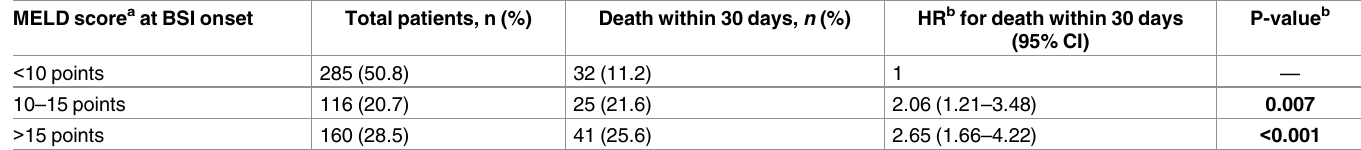
Table 3. 30-Day All-Cause Mortality in Patients with Staphylococcus aureus Bloodstream Infection Stratified by the MELD Score Category at Bloodstream Infection Onset (n = 561). MELD score a at BSI